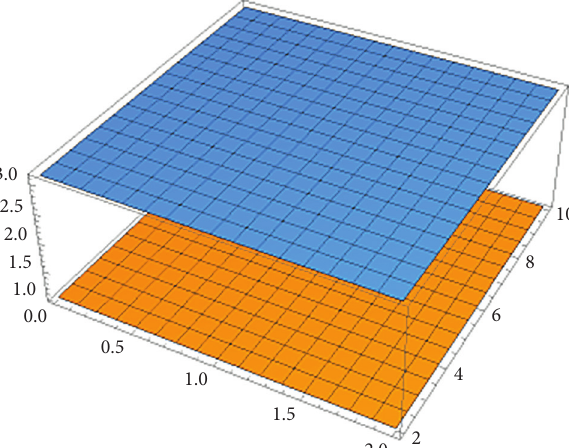
Figure 6: Dominance of the right-hand side of equation (35) is visually checked for τ ∈ [ 0 , 2 ] , υ > 2.